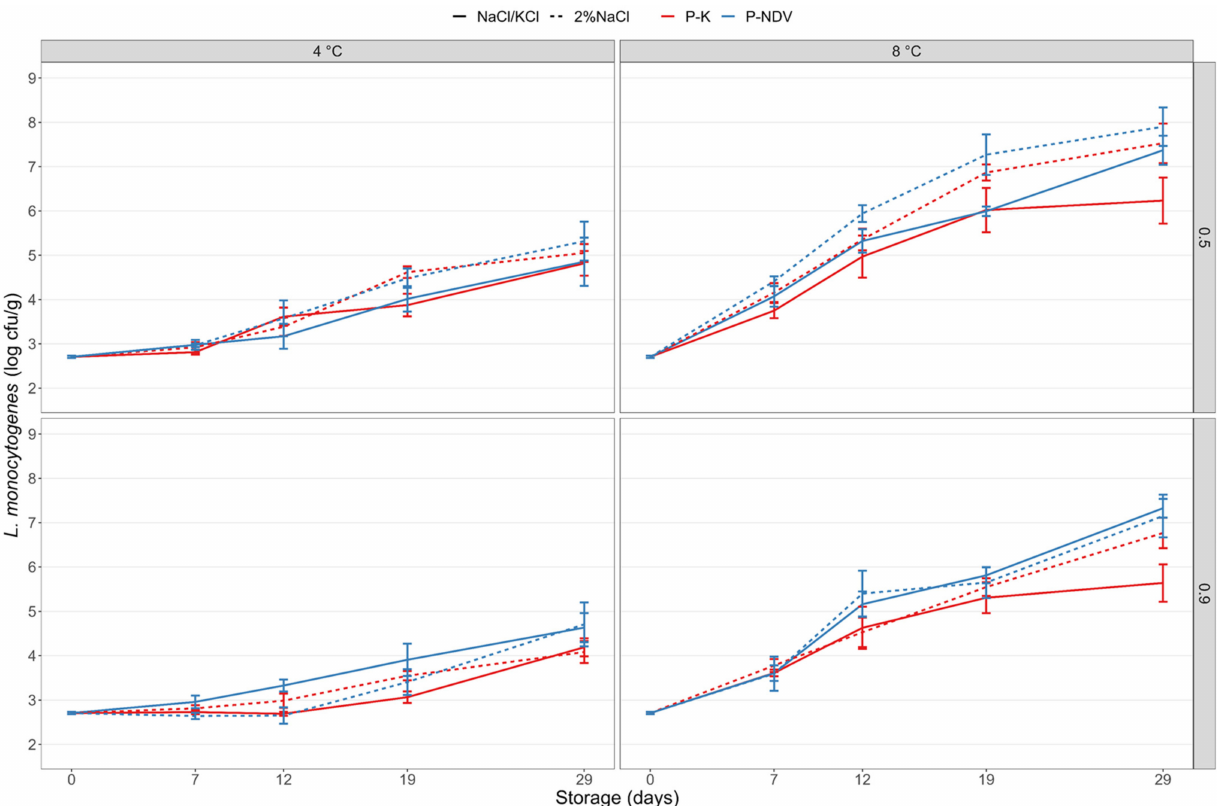
Figure 5. Growth of L. monocytogenes in CS-salmon added 3.0% (2.4% NaCl + 0.6% KCl) and 2.5% (2.0% NaCl + 0.5% KCl) mineral salts and Provian K or Provian NDV at levels of 0.5% and 0.9% in the salting process. The CS salmon were inoculated at Day 0 and stored under vacuum at 4 ◦ C and 8 ◦ C for 29 days. Mean values of two experiments (four to eight measurements per data point) and standard error of the mean are